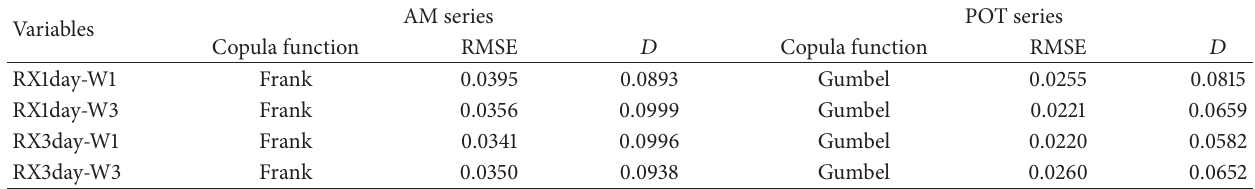
Table 5: Optimal function and evaluation indicators of 2D joint distribution for AM and POT